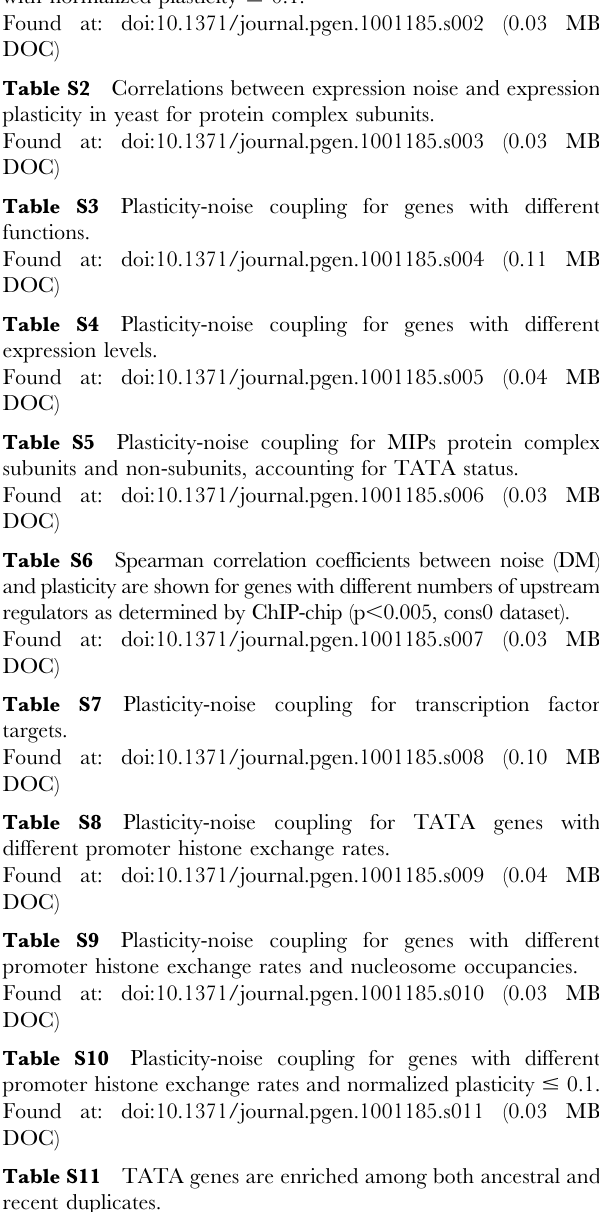
Table S1 Correlation between expression noise and expression plasticity in yeast for different gene sets, only considering genes with normalized plasticity # 0.1.